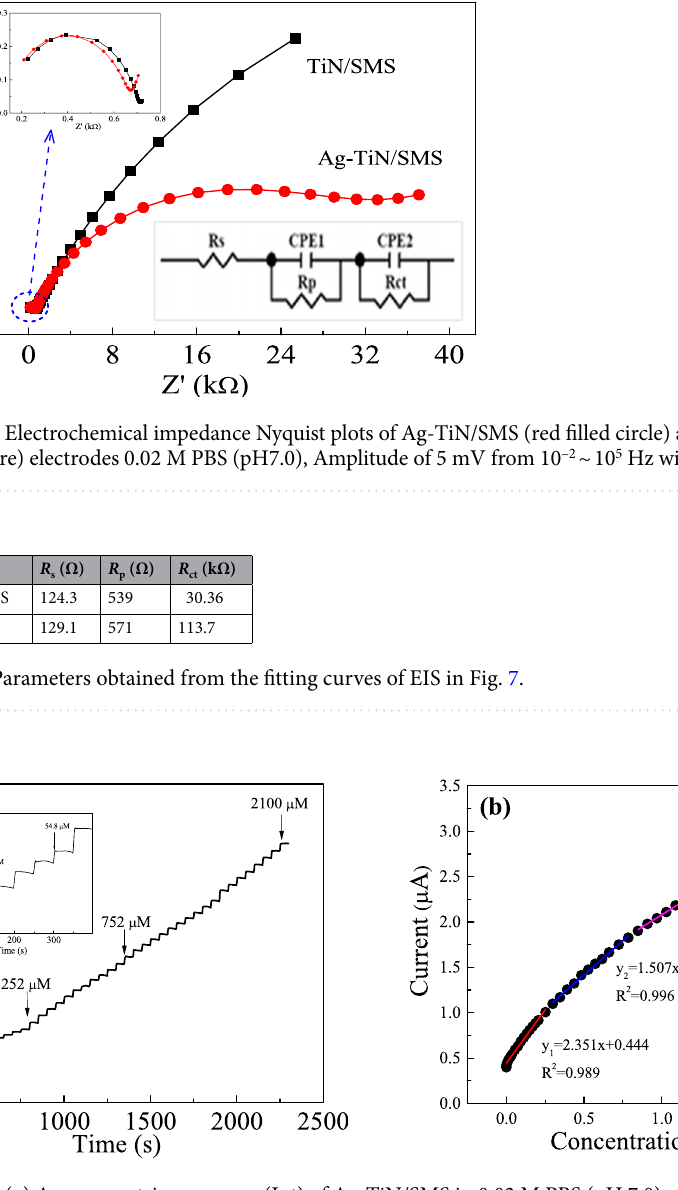
Figure 8. ( a ) Amperometric responses (I–t) of Ag-TiN/SMS in 0.02 M PBS (pH 7.0) with the successive adding H 2 O 2 ; ( b )The current concentration (I–C) linear fitting results for Ag-TiN/SMS.